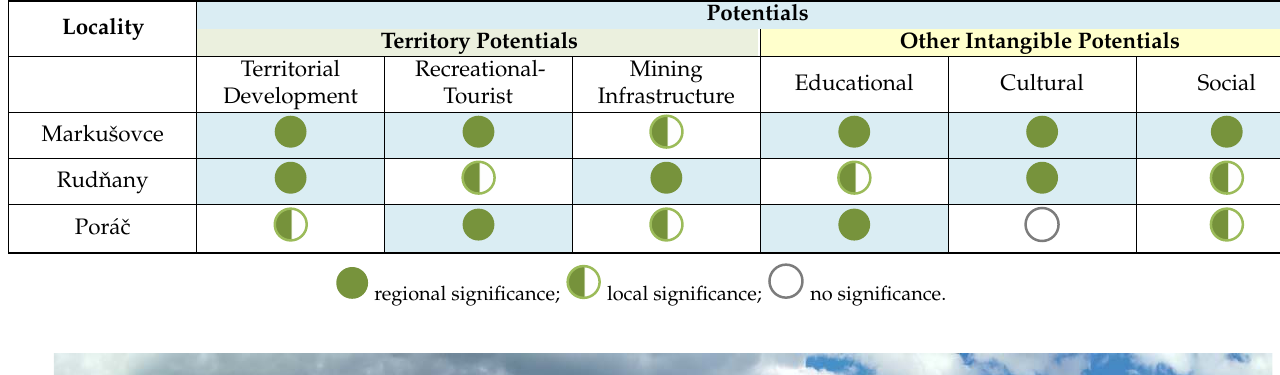
Table 2. Potentials of the location. Figure 5. Panorama of the solved site (photo Záveská, K.).